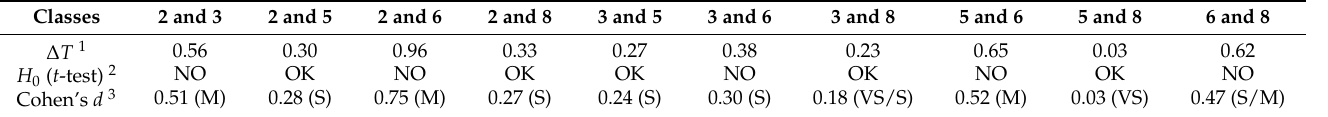
Table 8. Results of the t -tests and values of Cohen’s d for each pair of artificial classes (study period 2018–2021).